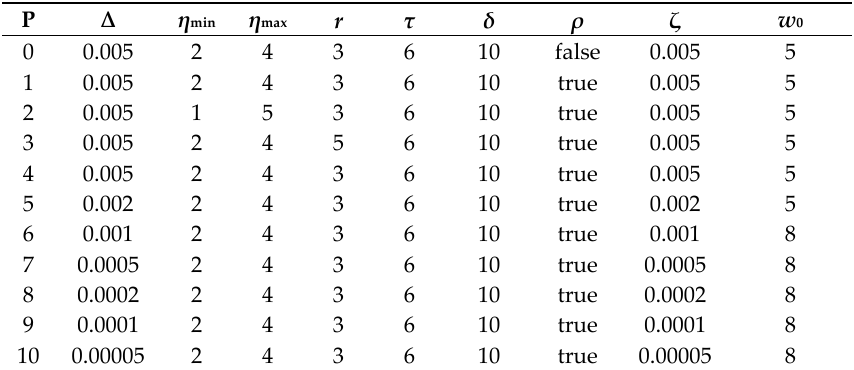
Table 1. Parameter sets.